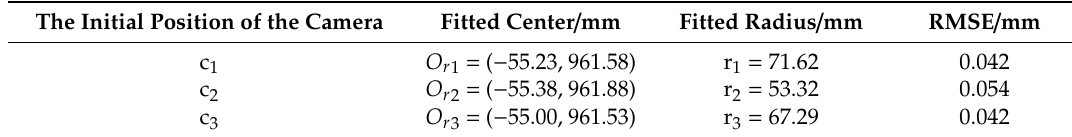
Figure 12. Photocentric coordinate distribution map.